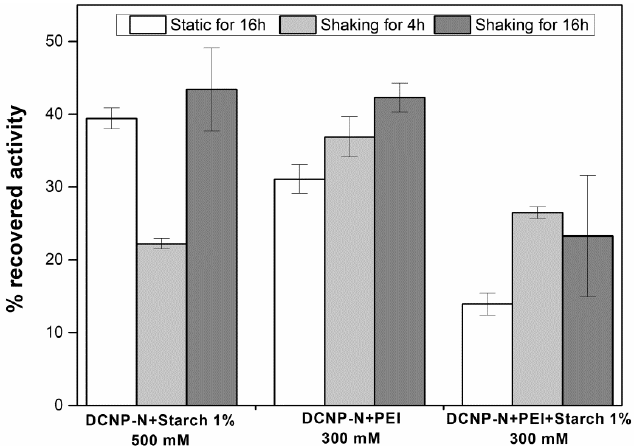
Figure 10. Comparison of the effect of agitation and crosslinking time on the recovered activity of CLEAs of AMG prepared as following: co-aggregation with the magnetic nanoparticles DCNP-N and 1% ( w / v ) starch and crosslinking with 500 mM glutaraldehyde (DCNP-N+Starch 1%-500 mM); co-aggregation with the magnetic nanoparticles DCNP-N and polyethyleneimine (PEI) and crosslinking with 300 mM glutaraldehyde (DCNP-N+PEI-300 mM); co-aggregation with the magnetic nanoparticles DCNP-N, 1% ( w / v ) starch and PEI and crosslinking with 300 mM glutaraldehyde (DCNP-N+PEI+Starch 1%-300 mM). All CLEAs were prepared at 4 °C, mass ratio protein/DCNP-N of 1:1, precipitation with ethanol at volume ratio 1:9 (enzyme solution:ethanol). Values are shown as the mean of duplicate experiments ± s.d.